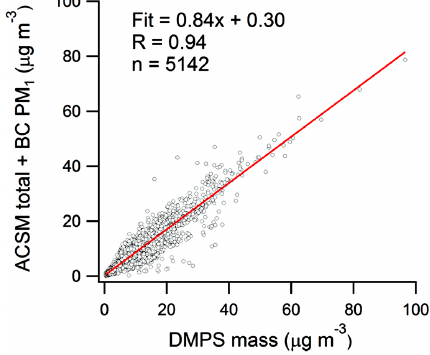
Fig. 2. Scatter plot of NR-PM 1 + BC mass vs. calculated DMPS